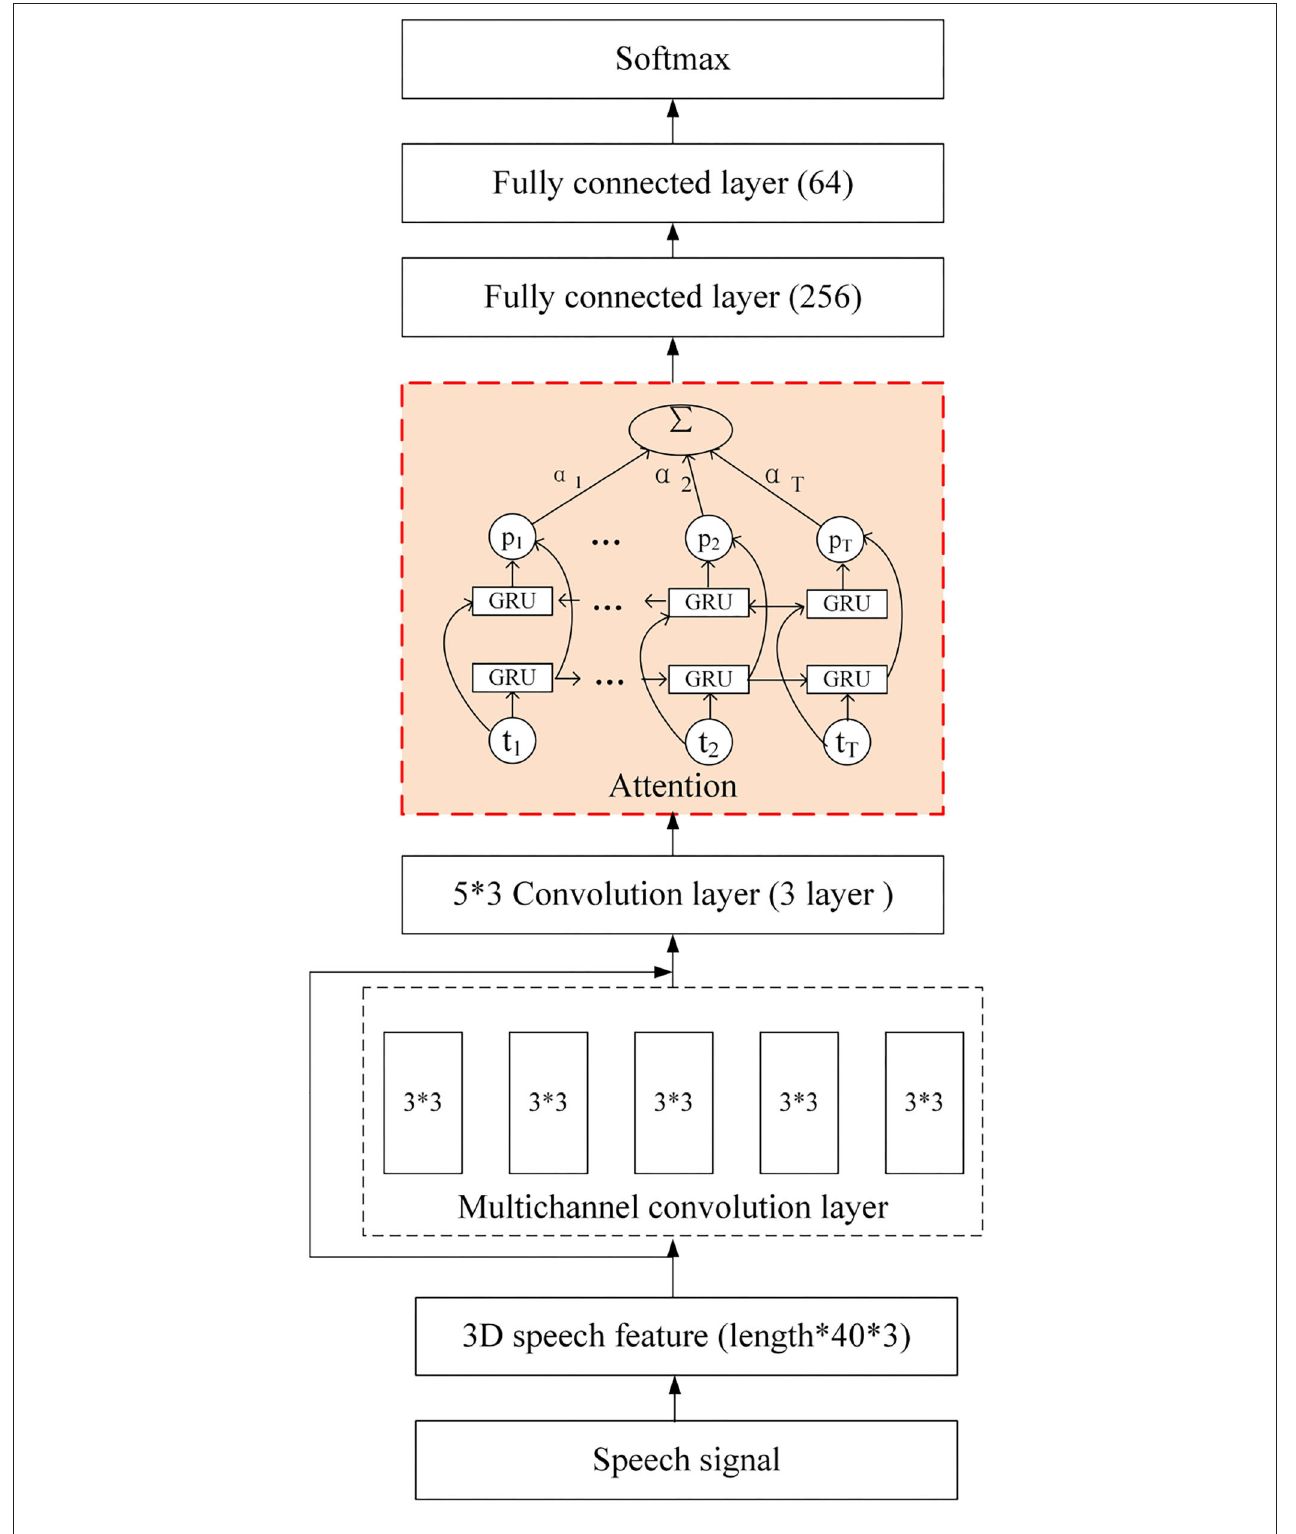
FIGURE 10 | 3D-CBHGA network configuration